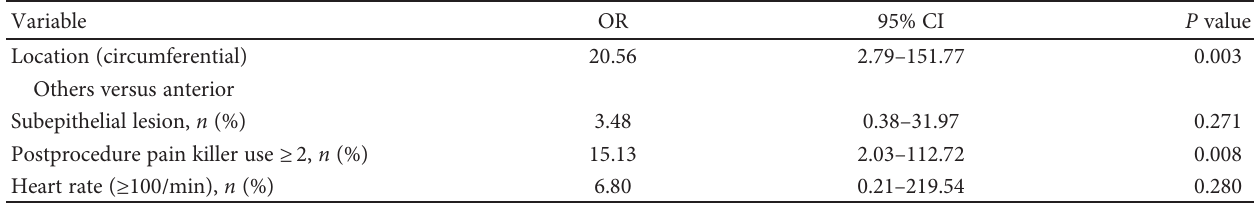
Table 4: Multivariate logistic regression analysis of risk factors for surgery caused by gastric perforation after endoscopic resection. Variable OR 95% CI Location (circumferential) Subepithelial lesion, n (%)